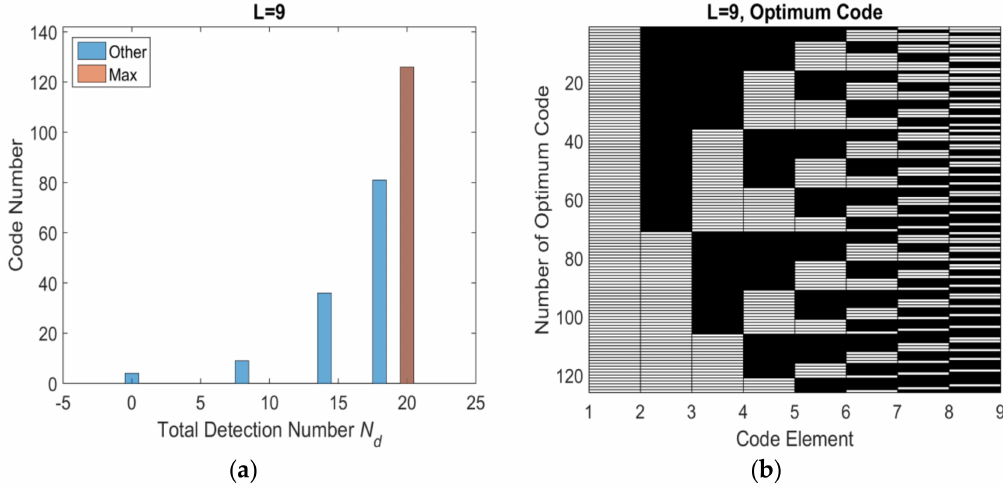
Figure 7. L = 9 optimum codes and corresponding N d ( a ) histogram distribution of N d ( b ) optimum codes.